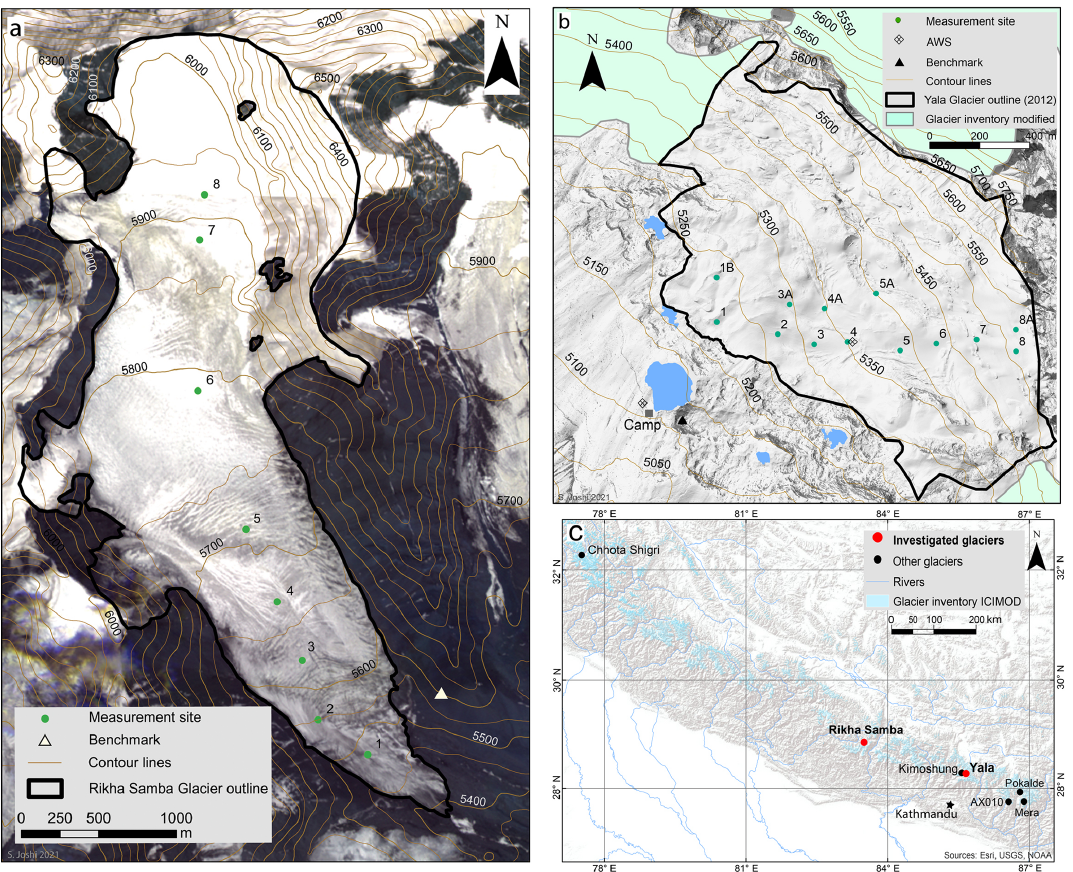
Figure 1. The study sites Rikha Samba and Yala glaciers showing the measurement sites and their location in the Himalaya. At all mea- surements sites stakes were installed. Snow pits were dug at the top stakes, and at selected lower stakes provided snow was present. (a) For Rikha Samba Glacier RapidEye orthoimages from April 2010 were used for the background image and glacier outlines. The contour lines are derived from the SRTM-3 DEM. (b) For Yala Glacier, GeoEye-1 orthoimages from January 2012 were used for the background image and in combination with dGNSS data for the glacier outlines. The contour lines are derived from the DEM2012 generated from the GeoEye-1 stereo images. (c) The overview map shows the location of the two investigated glaciers and other glaciers mentioned in the discussion section. The glacier inventory is from ICIMOD (Bajracharya et al.,